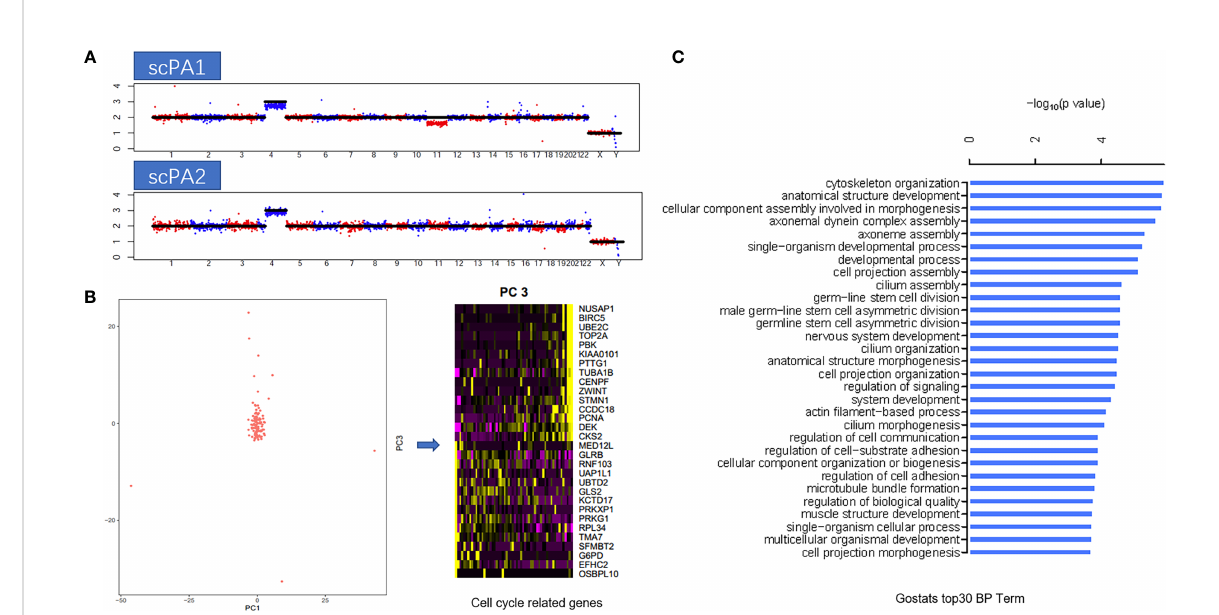
FIGURE 3 (A) Copy number variation (CNV) pro fi les of the two specimens: fi rst surgery(scPA1) and second surgery(scPA2), show gain in chromosome 4 (both), and chromosome 11 deletion in scPA1 only, indicated the possible existence of temporal and spatial heterogeneity within the tumor. (B) Principal component analysis (PCA) showed that the cells were almost clustered together, and only little part of cells (7/209) had cell cycle heterogeneity (PC2 represented cell cycle related genes). (C) GO enrichment analysis of the differentially expressed genes of this case, the top 30 biological processes (BP) term were